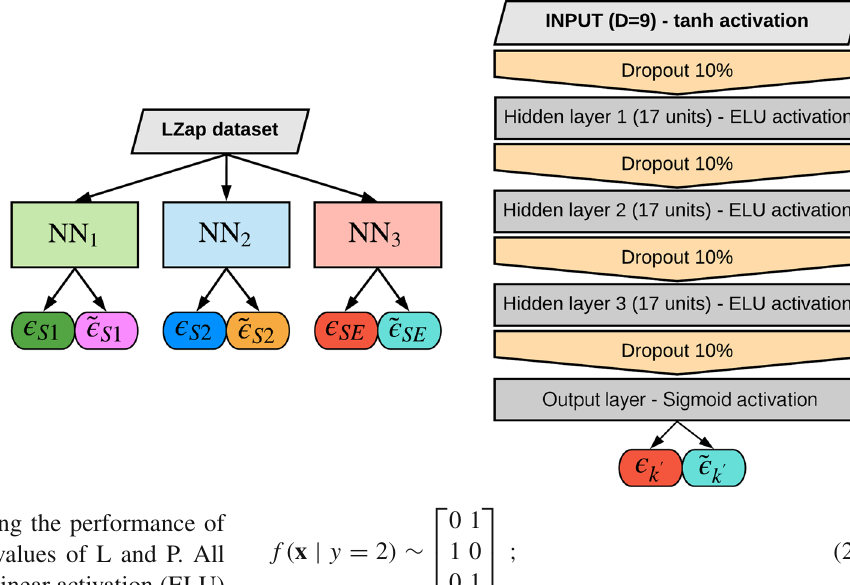
Fig. 7 Simplified schematic of the TriNet Classifier model (left). The model is composed of an ensemble of three NN models (right) each trained to separate the three main pulse classes in the data: S1, S2 and SE pulses. The outputs of each NN classifier, ˆ y k (cid:3) = { (cid:2) k (cid:3) , ˜ (cid:2) k (cid:3) } , represent the response and anti-response of the classifier to its respective